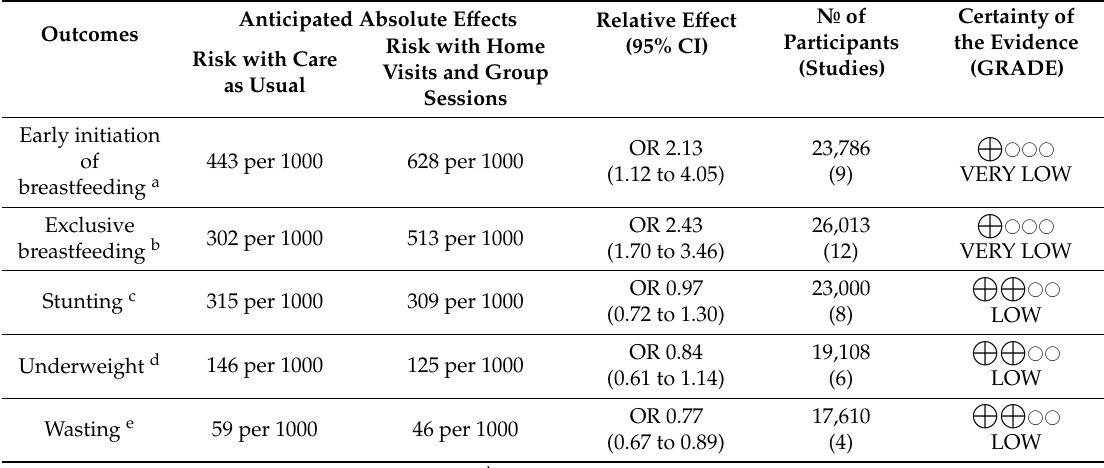
Figure 6. Forest plot of the meta-analysis of exclusive breastfeeding for home visits and mother/peer groups.